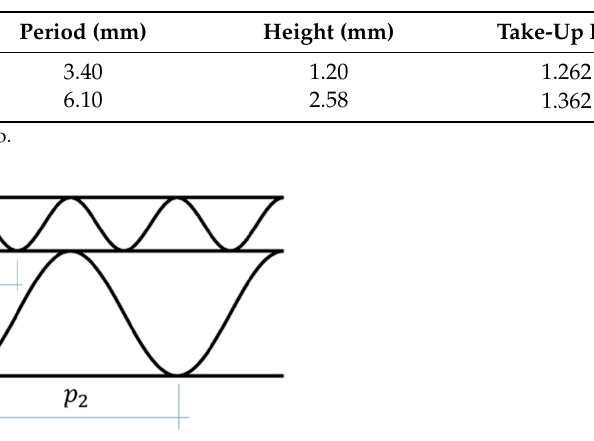
Table 2. Geometrical parameters of corrugated layers.